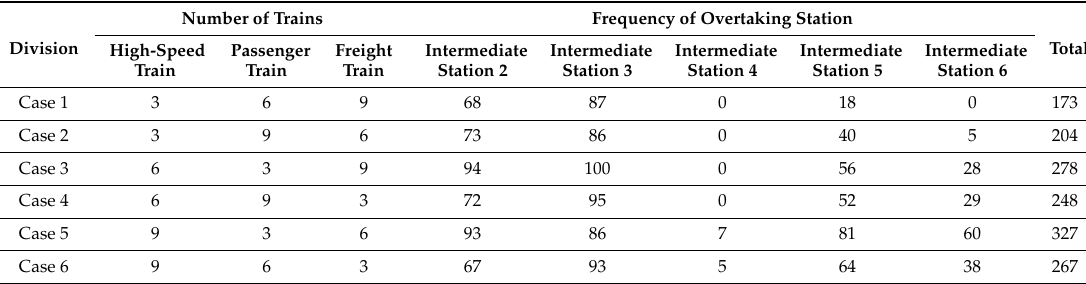
Table 14. Frequency of overtaking station for each